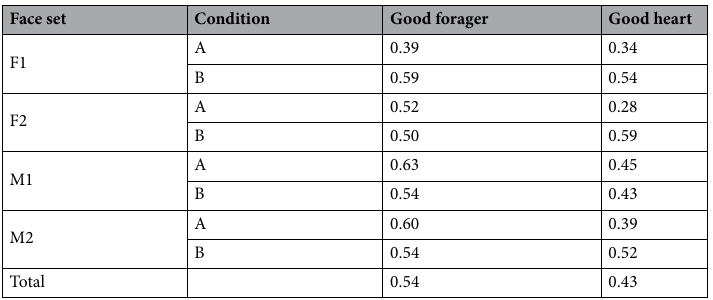
Table 1. Proportion of responses choosing anomalous face by face set, condition, and trait. Numeric values are the proportion of responses that chose the anomalous face for that trait. Face sets with women are notated with “F” and face set with men are notated with “M.” The only difference between conditions was which face had the photoshopped scar.